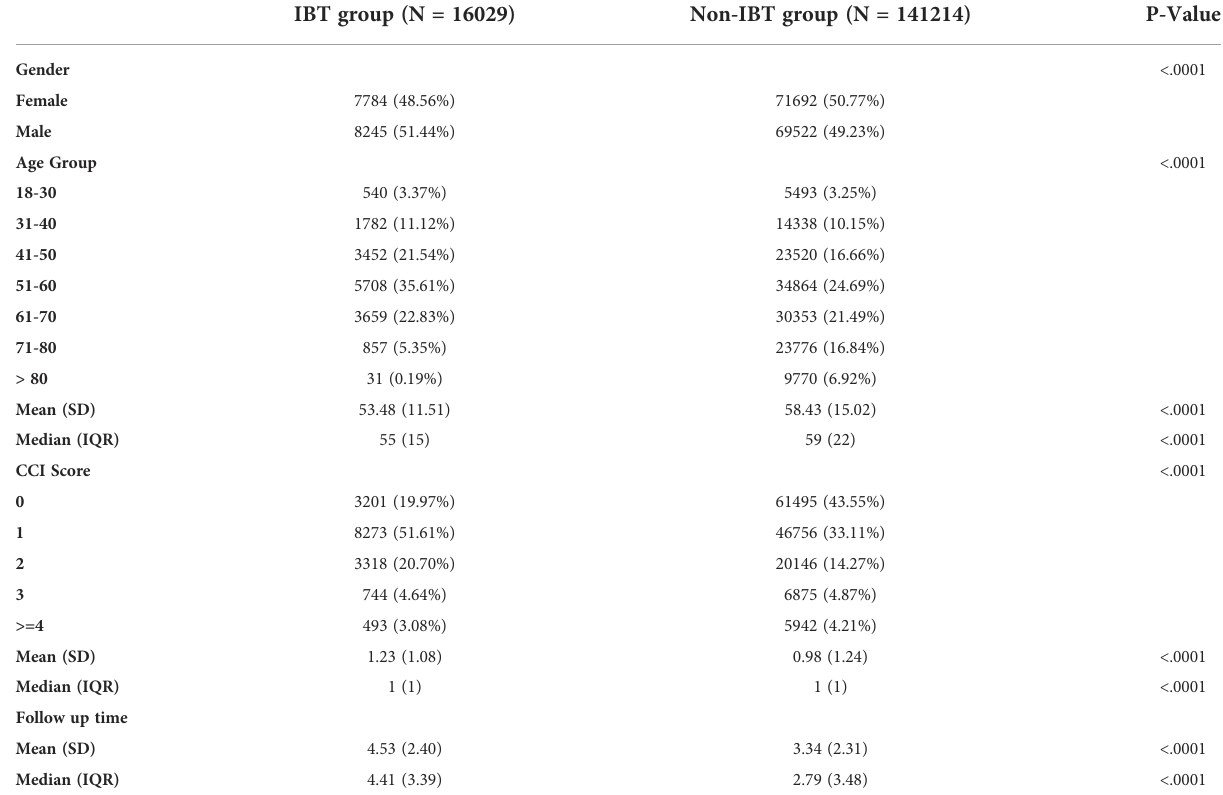
TABLE 1 Baseline Characteristics of IBT and Non-IBT